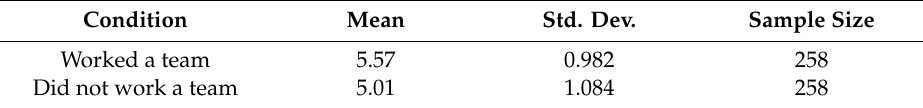
Table 5. Trust in the physician who worked in a team and the one who did not. Condition Std. Dev.